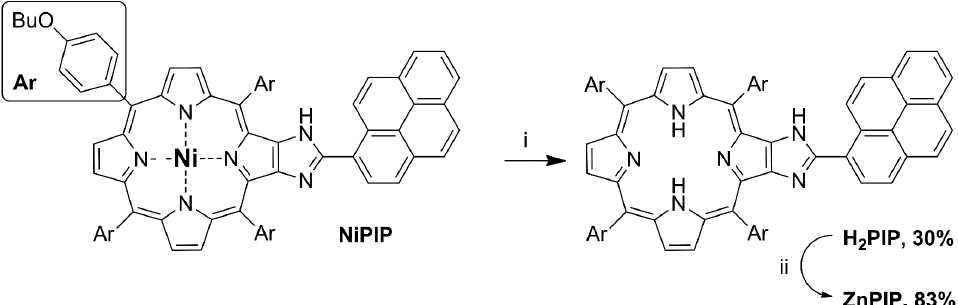
Figure 2. The normalized by maximum UV-vis absorbance and fluorescence spectra of ZnPIP in toluene. The observed spectra demonstrate that the D and A moieties of H 2 PIP and ZnPIP are able to fluoresce as independent or partially dependent fluorophores. Therefore, concern- ing the highlighted spectral characteristics of both dyads, we can focus on the set of their fluorescence bands that can further be used in quantifying the interaction with analytes. To do this, we aim to use numerical values of the emission peak intensities for both D and